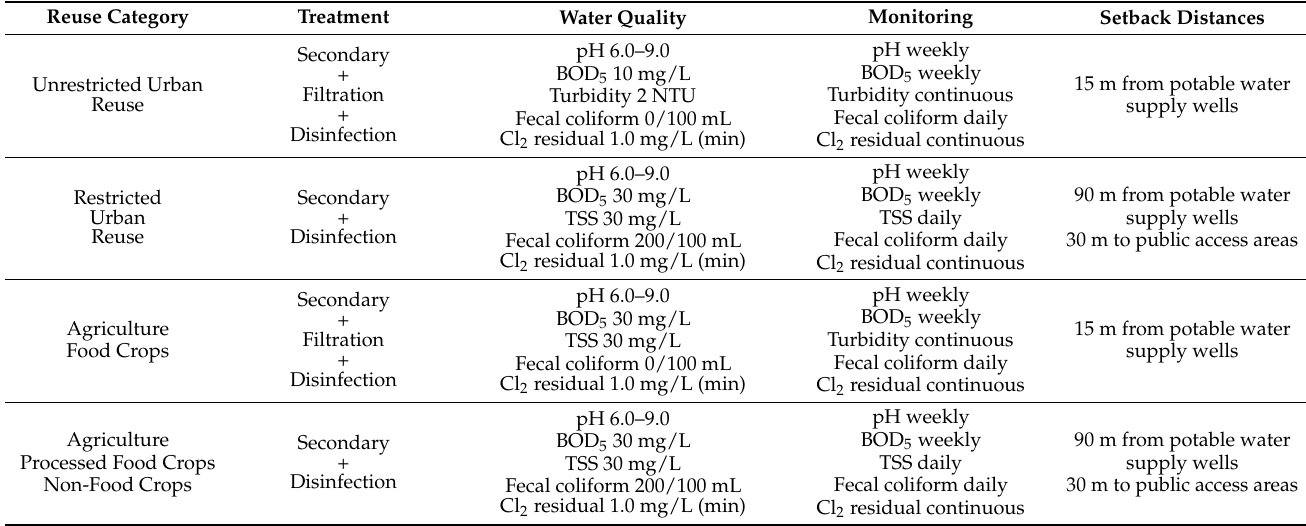
Table 3. EPA suggested regulatory guidelines for irrigation wastewater reuse